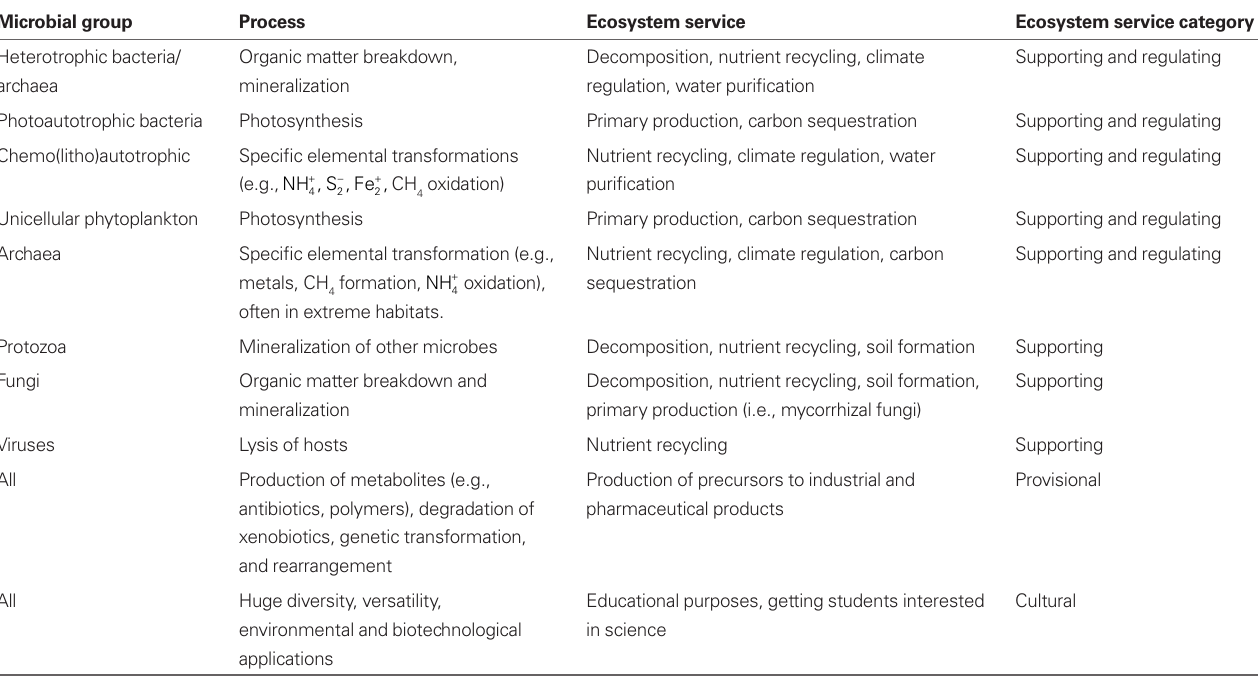
Table 1 | Major groups of microbes and ecosystem services they